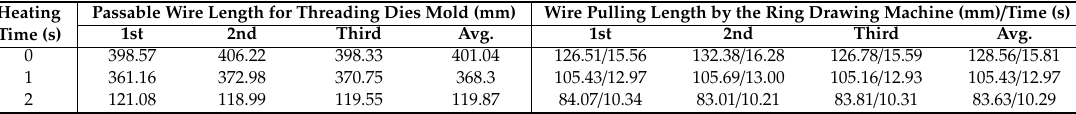
Table 15. Results based on wire pulling speed: k4(8.13 mm / s).